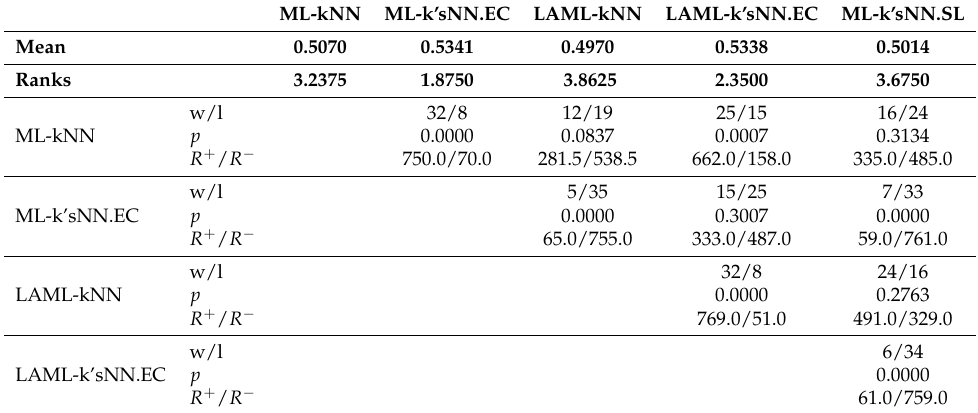
Table 6. Comparison of the different methods using average precision metric.